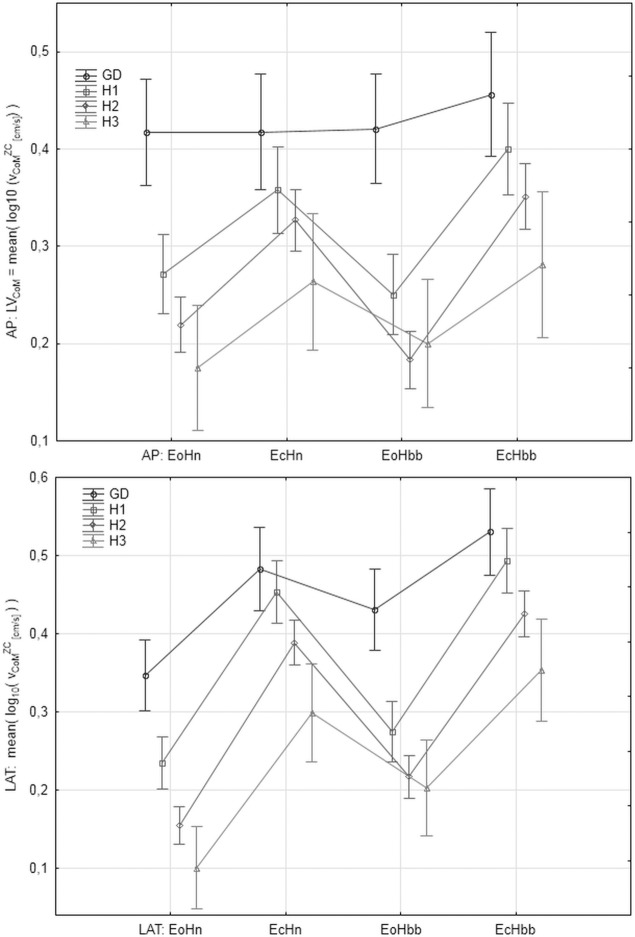
The mean values of LVCoM = mean(log10(vCoMZC)) in the subsequent patients and registration condition groups.vCoMZC represents the velocity of xCoM signal in the given Zero-Crossing point. Upper: antero-posterior (AP), bottom: lateral (LAT) component of the signal. Markers denote the standard error of the mean.